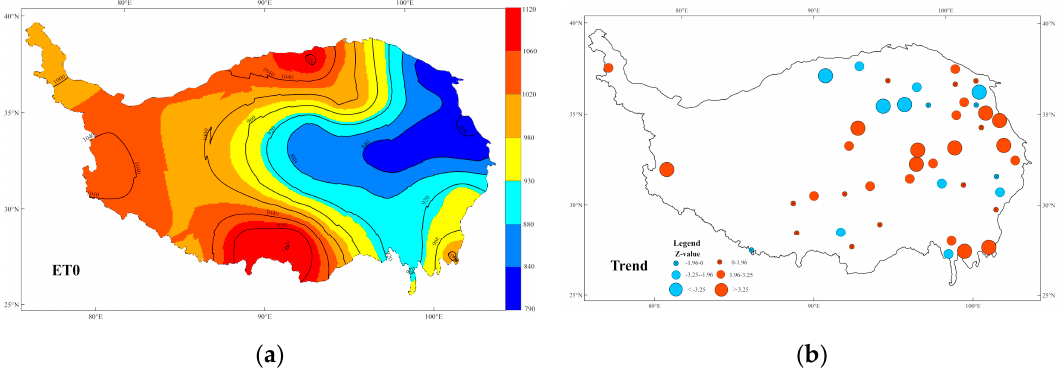
Figure 7. ( a ) The distribution of the multi-year average ET 0 in the Tibetan Plateau (TP); ( b ) the distribution of the statistical value Z of the Mann–Kendall test at each station of TP from 1961 to 2017. At the α = 0.05 significance level, if | Z | > 1.96, ET 0 changes significantly. The red bubble represents the increasing trend, the blue bubble represents the decreasing trend, and a larger bubble size suggests an increased